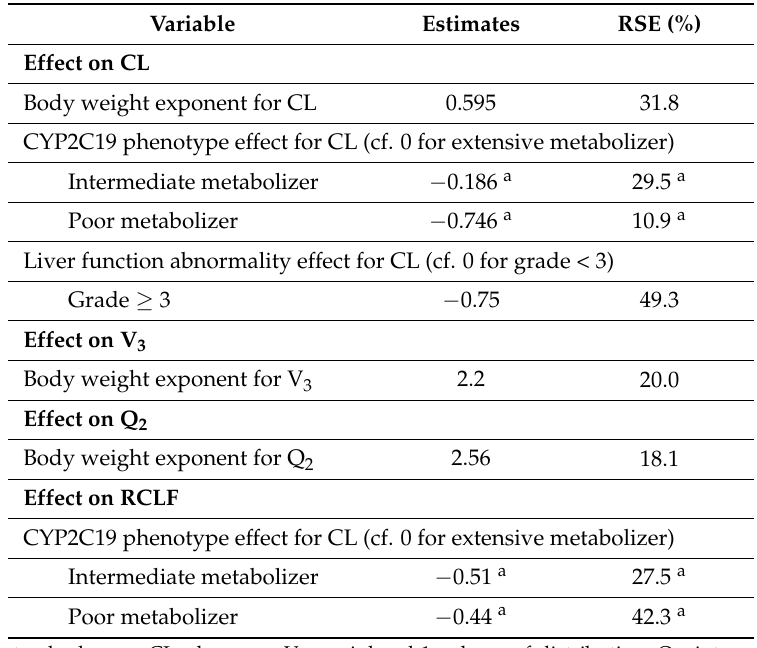
Table 3. Significant covariate effects on the population pharmacokinetic parameters in the final model.